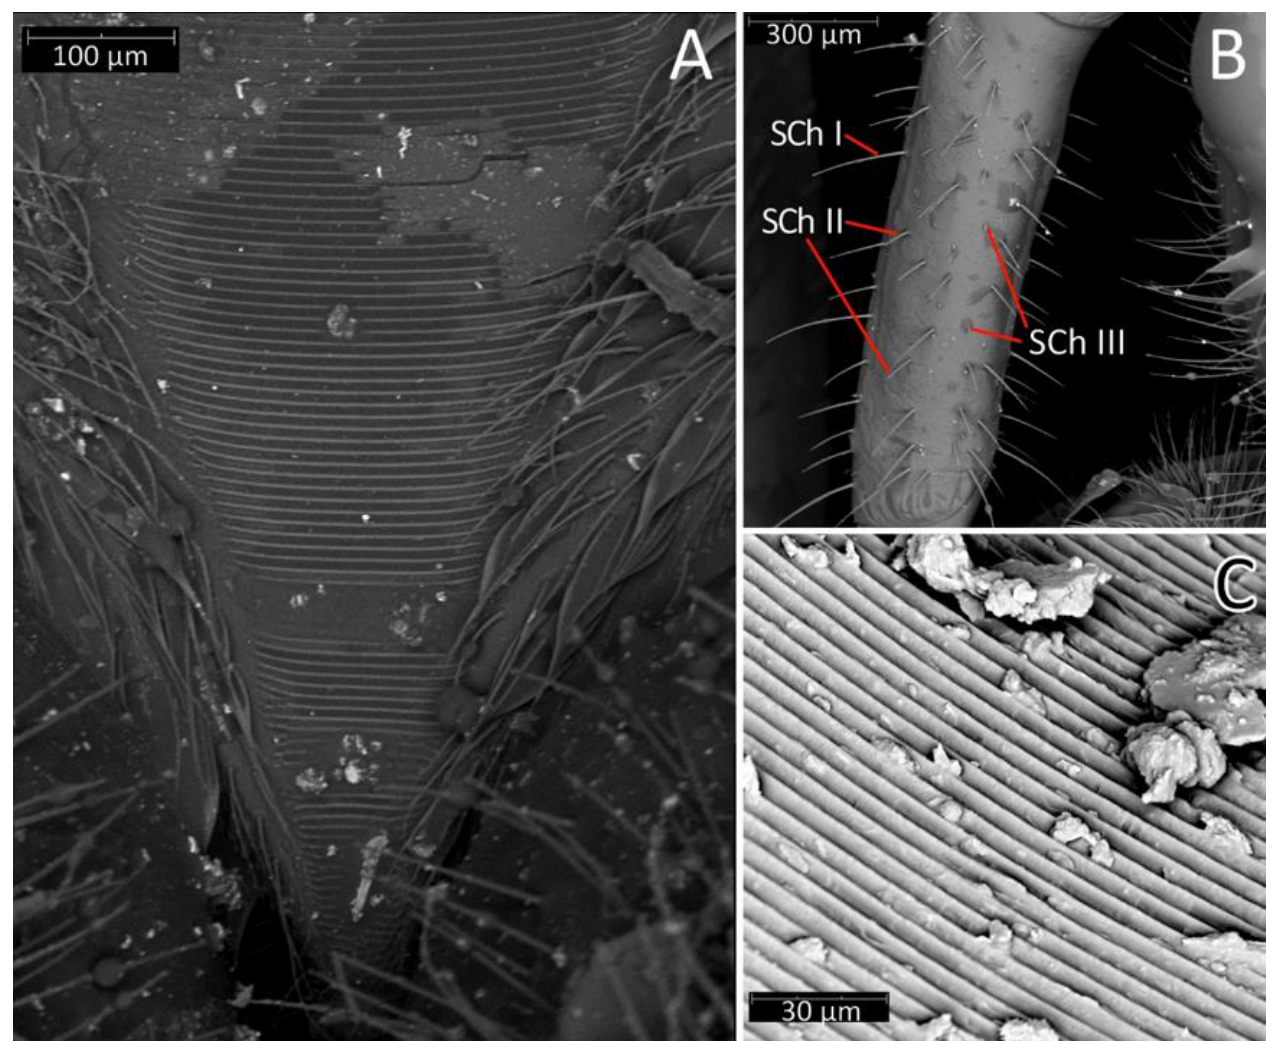
Figure 12. ( A ) Prostemal stridulatory organ of Phonoctonus fasciatus (Beauvois, 1805). ( B ) Third segment of the rostrum of P. immitis Stål, 1865 with different types of sensilla chaetica. ( C ) Magnification of the transverse ridges of prostemal stridulatory organ of P. fasciatus (Beauvois, 1805), which are rubbed by the plectrum. SCh I —sensillum chaeticum type I; SCh II —sensillum chaeticum type II; SCh III —sensillum chaeticum type III.